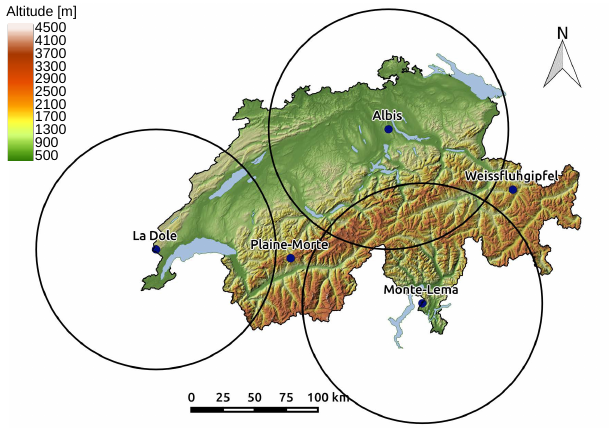
Figure 1. Location of the Swiss operational radars. The three radars used in the context of this study are surrounded by black circles which indicate the maximum range of radar data (100km) used for the evaluation of the radar operator (Sect. 4.3). Note that as they were installed only quite recently, no data from the Weissfluhgipfel and Plaine Morte radars were used in this